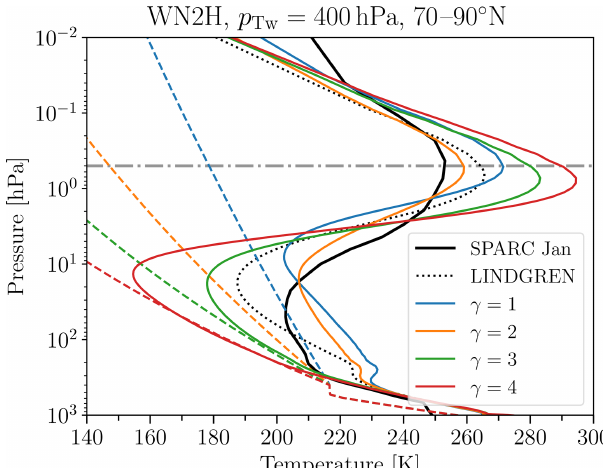
Figure 10. Same as Fig. 9 but for model simulations with WN2 tropospheric heating of amplitude q 0 = 6Kd − 1 and different polar vortex lapse rates γ for p Tw = 400hPa. The temperature profiles obtained from a simulation with the original Lindgren setup (dotted black line) are added for